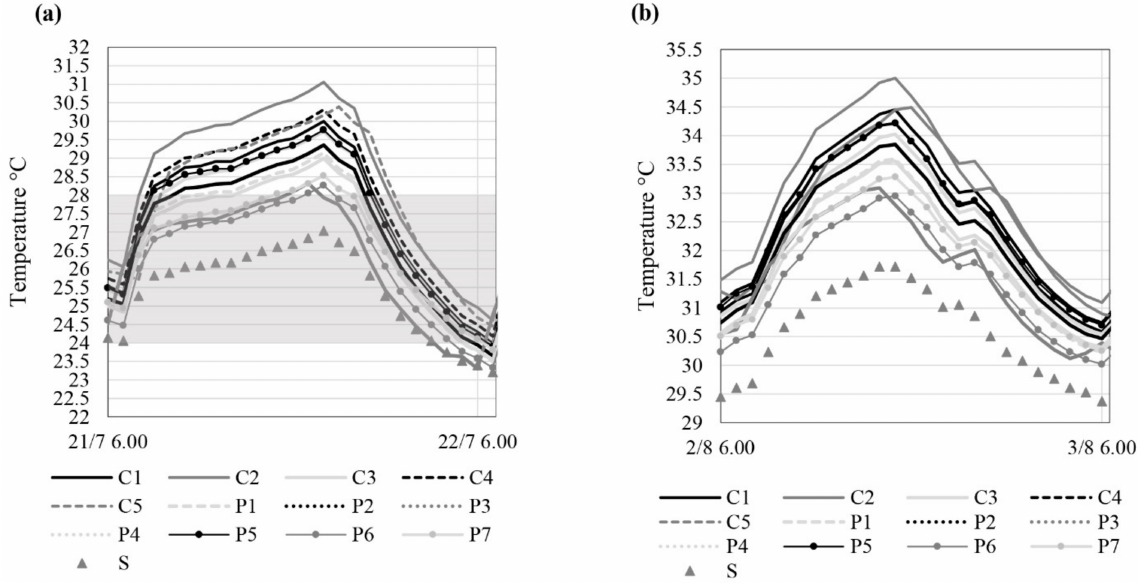
Figure 8. Interior temperature achieved on the hottest day of the year in Monfero ( a ) and Turin ( b ).